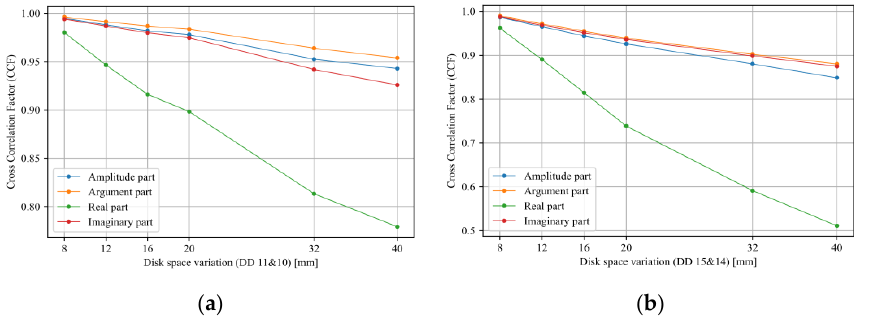
Figure 11. Feature variations based on the severity of the DSV fault in different locations for extracted by the CCF index: ( a ) DSV in DD 11 and 10 ( b ) DSV in DD 15 and 14.